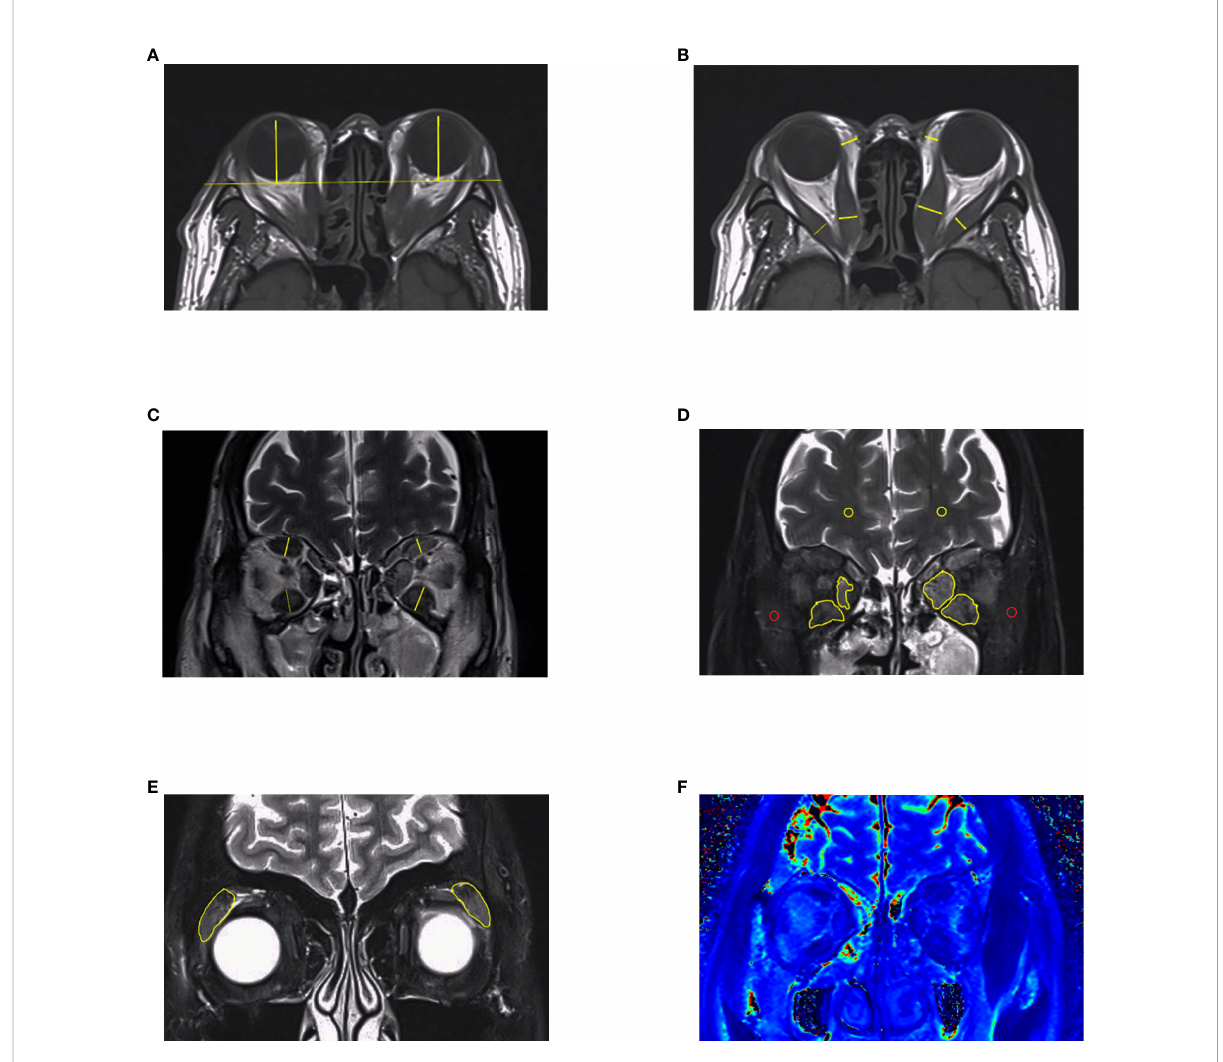
FIGURE 3 MRI measurements in GO. (A – C) Length parameters such as proptosis, thickness of extraocular muscles and thickness of orbital fat. It is noteworthy that thickness of medial rectus and lateral rectus muscles should be measured in axial images. (D, E) Signal intensity of extraocular muscles and lacrimal glands got from Dixon-T2WI sequence. The signal intensity of temporalis muscle (red circle) or white matter (yellow circle) on the same slice was used to calculated signal intensity ratio (SIR). (F) EOMs displayed on T2 mapping. This fi gure is